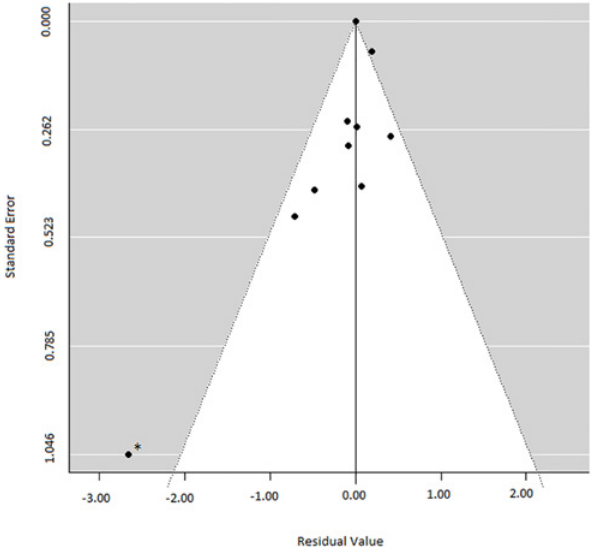
Fig 5. Funnel plot of included studies. * Potential outlier. Study by Marzolini et al (2009) [42].